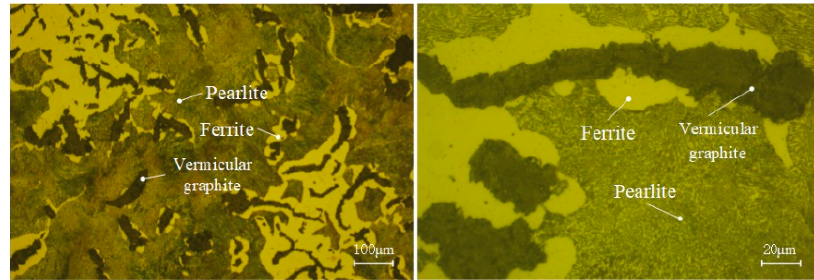
Figure 3. Crystal phase diagram of CGI.